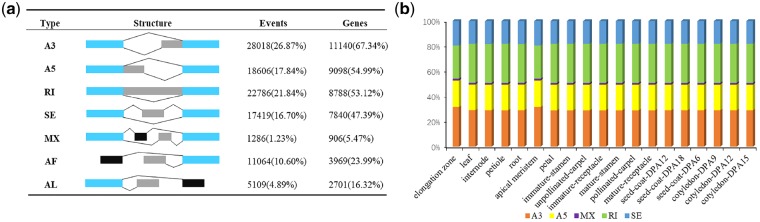
Characterization of AS events and percentage of AS events in tissues. (a) Characterization of AS events. Seven different types of AS events were showed. The number of AS events and corresponding percentage of all AS events were calculated. The number of gene associated with AS event and proportions of these genes occupying all genes undergoing AS. (b) Distribution of five main types of AS events in different tissues.